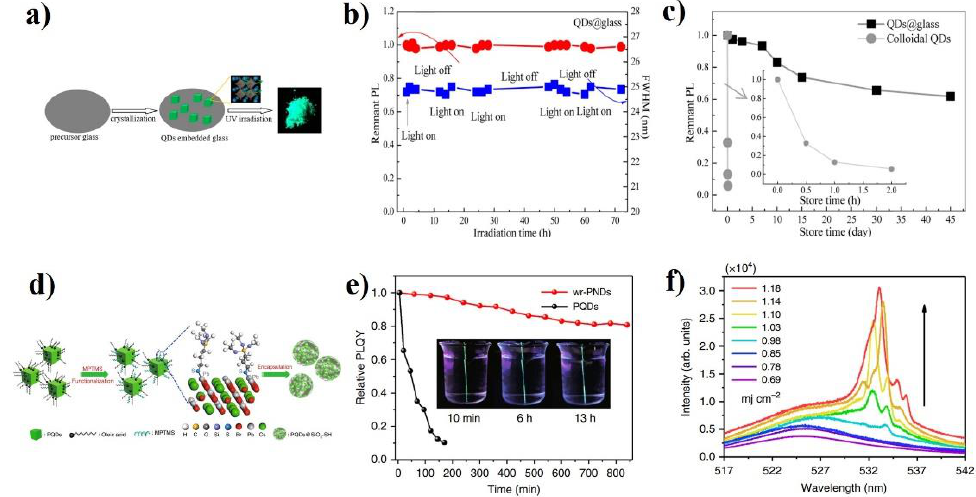
Figure 2. ( a ) Glass crystallization strategy to fabricate QD-embedded glass. ( b ) Photostability test of QDs@glass illuminated with 365 nm UV lamp: remnant PL intensity and the variation of FWHM as a function of the irradiation time. ( c ) Water resistance test by directly immersing QDs@glass in aqueous solution: remnant PL intensity vs. store time. The images ( a – c ) were adapted with permission from Ref. [64]. Copyright 2018 American Chemical Society. ( d ) Schematics of the synthetic procedure for making water-resistant perovskite QDs@SiO 2 nanodots. ( e ) Relative PLQYs of the laser devices were based on water-resistant perovskite QDs@SiO 2 nanodots (red dots) and pristine QDs (black dots), which were immersed in water for different periods. The insets are photographs of the nanodot-based laser in water taken at different times under UV light illumination. ( f ) Emission spectra of the water-resistant perovskite QDs@SiO 2 nanodot-based RL device stored in water for 15 days. The images ( d – f ) were adapted with permission from Ref. [73]. Copyright 2020 Springer